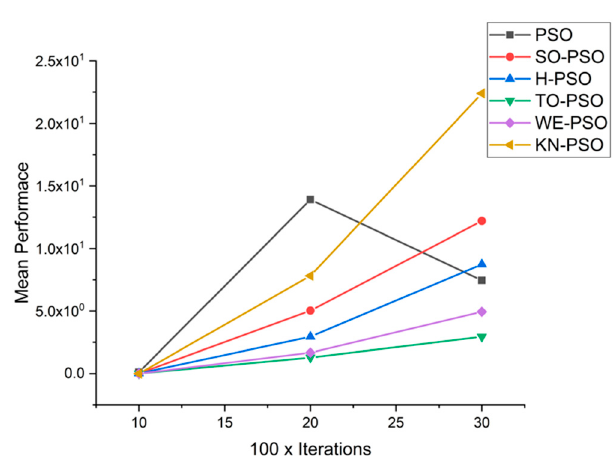
Figure 17. Convergence curve on fn11.